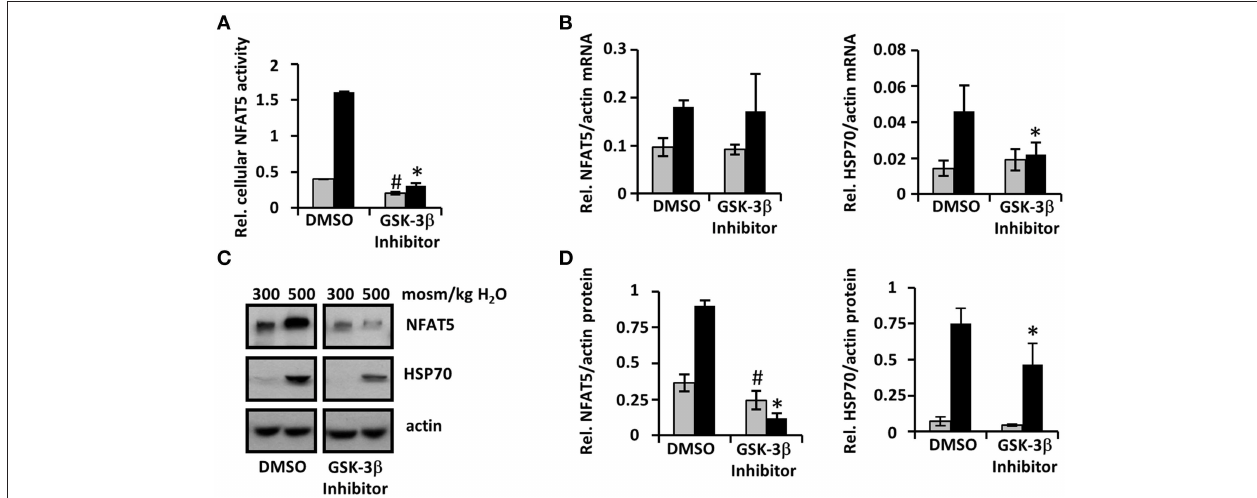
FIGURE 6 | GSK-3 β inhibitor VIII mimics the effect of lithium on cellular NFAT5 activity. HEK 293 cells stably transfected with a reporter construct in which the SEAP gene is under control of two TonE sites (A) or IMCD-3 cells (B–D) were incubated for 96h in isosmotic ( ; 300 mosm/kg H 2 O) or hyperosmotic ( (cid:4) ; 500 mosm/kg H 2 O) medium in the presence of 10 µ M GSK-3 β inhibitor VIII or vehicle DMSO (as control). (A) After 96h, SEAP activity was measured as described in Methods. Data are means ± SEM for n = 6 ; * P < 0.05 vs. hyperosmotic control; # P < 0.05 vs. isosmotic control. (B) IMCD-3 cells were processed for